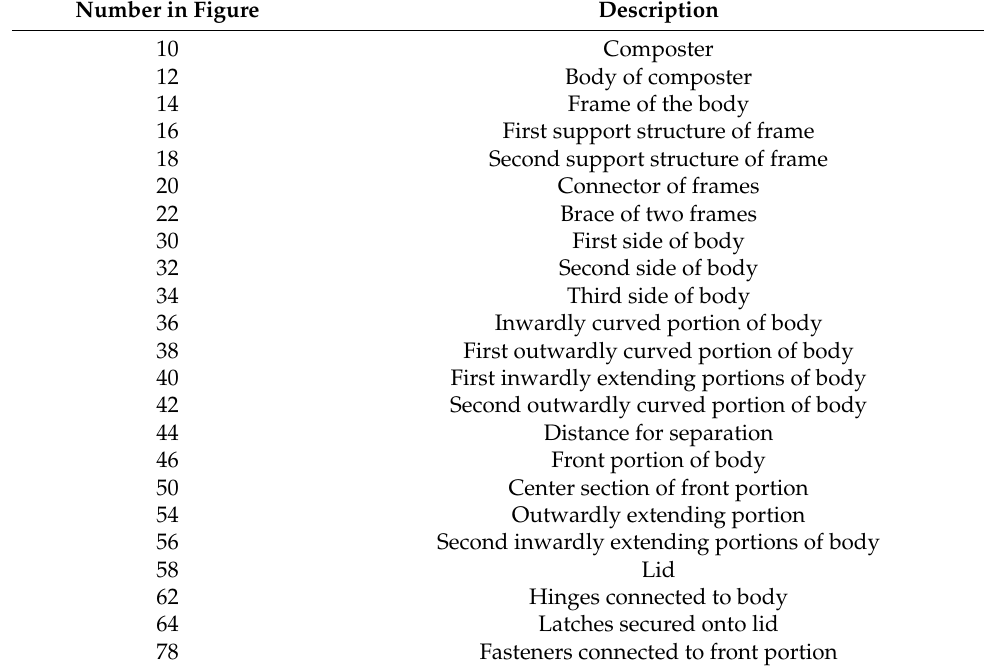
Table A2. An aerobic manual composter from CA2671248C